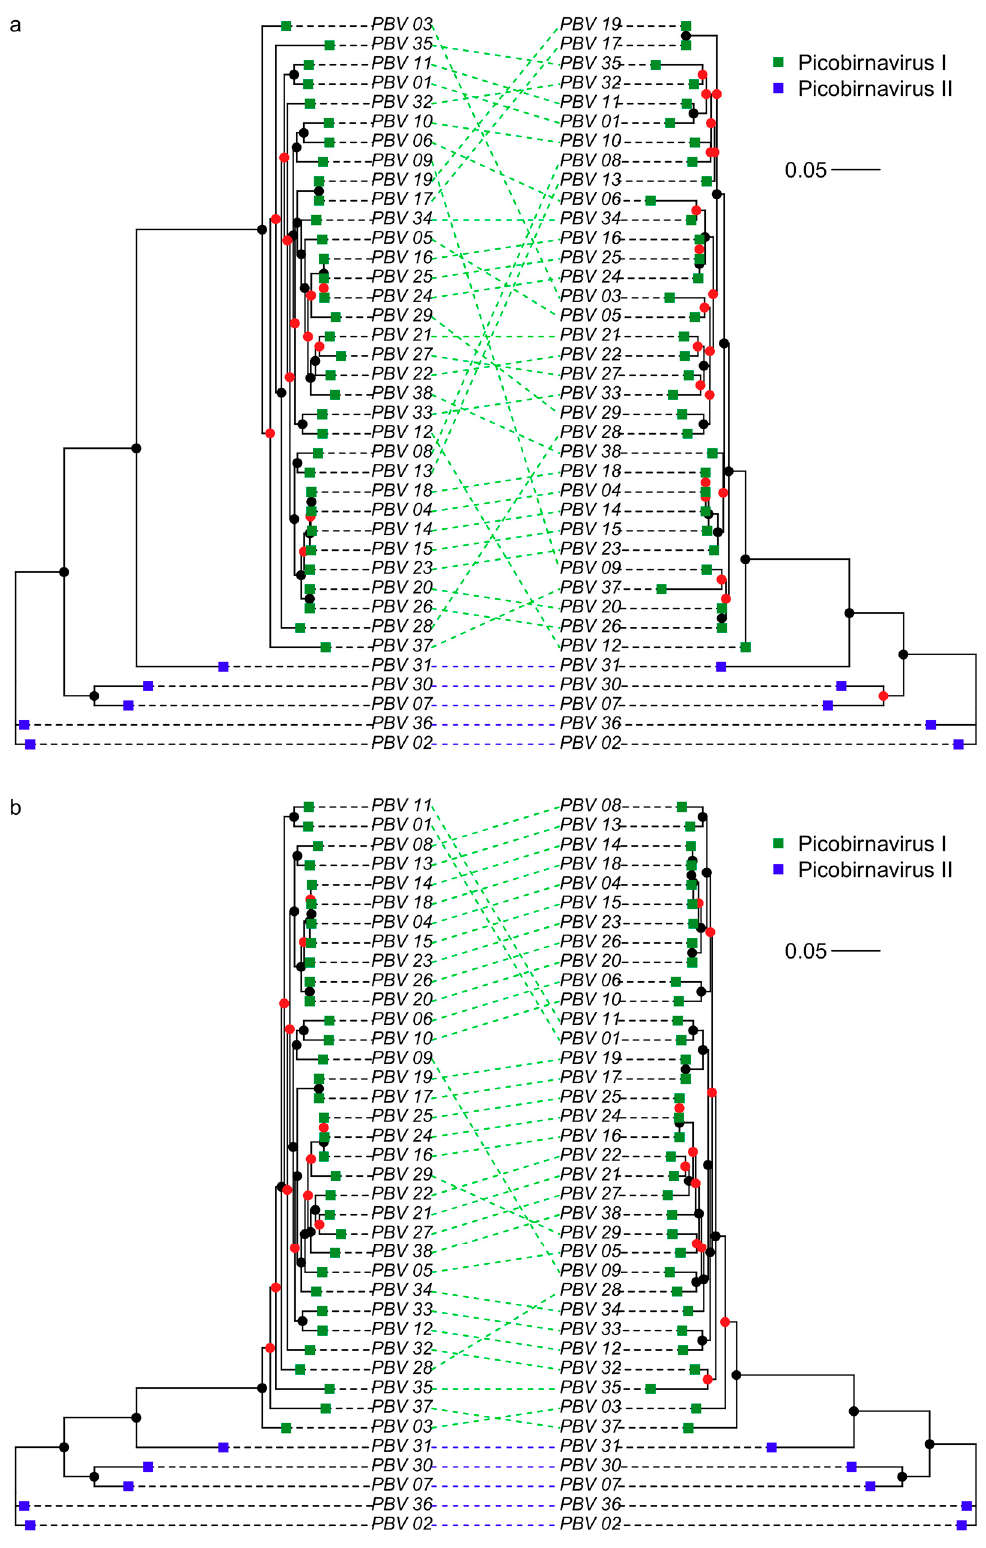
Figure 1. Cophylogeny ML trees of ( a ) trimmed complete v trimmed partial RdRp picobirnavirus amino acid sequences and ( b ) trimmed complete v untrimmed complete RdRp picobirnavirus amino acid sequences. Scale bar corresponds to 0.05 substitutions per amino acid. Branch support values are presented as coloured nodes (black >0.8, red <0.8).